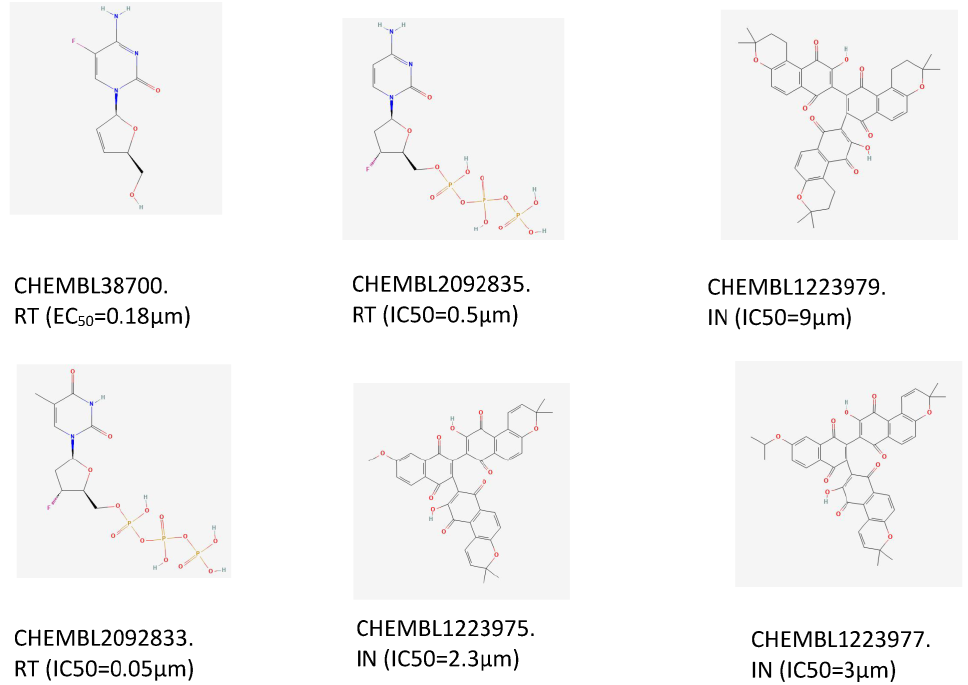
Figure 8. The 2D structures and bioactivity data of 6 compounds.